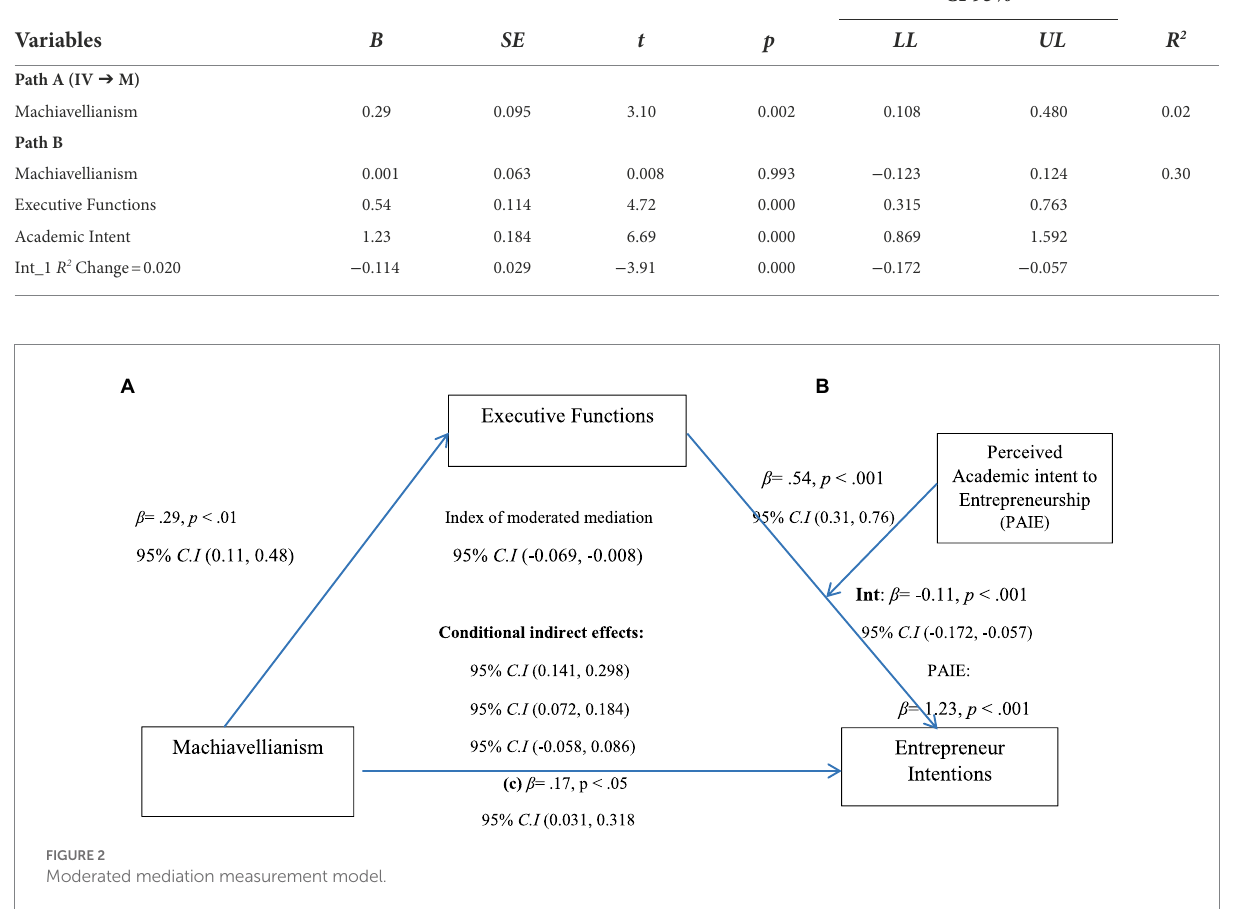
FIGURE 2 Moderated mediation measurement model.